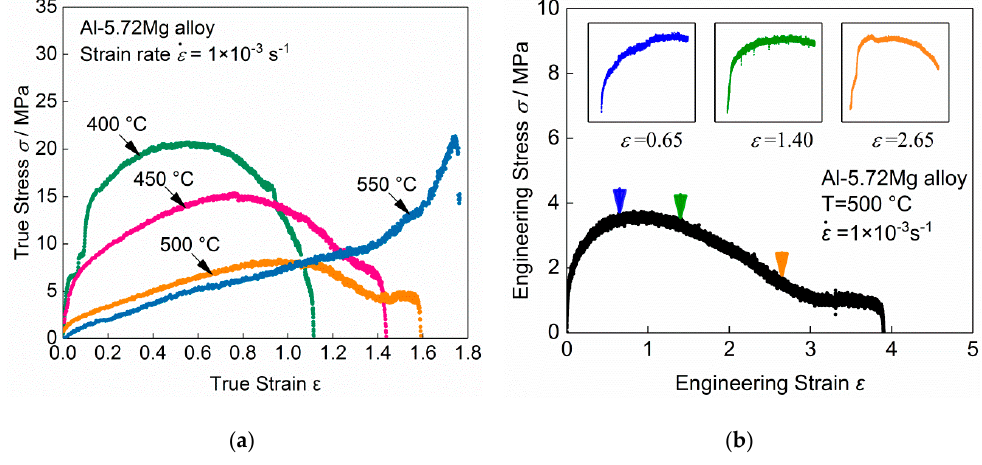
Figure 1. True stress–true strain results of 5A70 aluminum alloy at 400–550 °C and 1×10 − 3 s − 1 ( a ), and different superplastic tensile strain stages, ε = 0.65, 1.40 and 2.65, at 500 °C and 1×10 − 3 s − 1 ( b ).